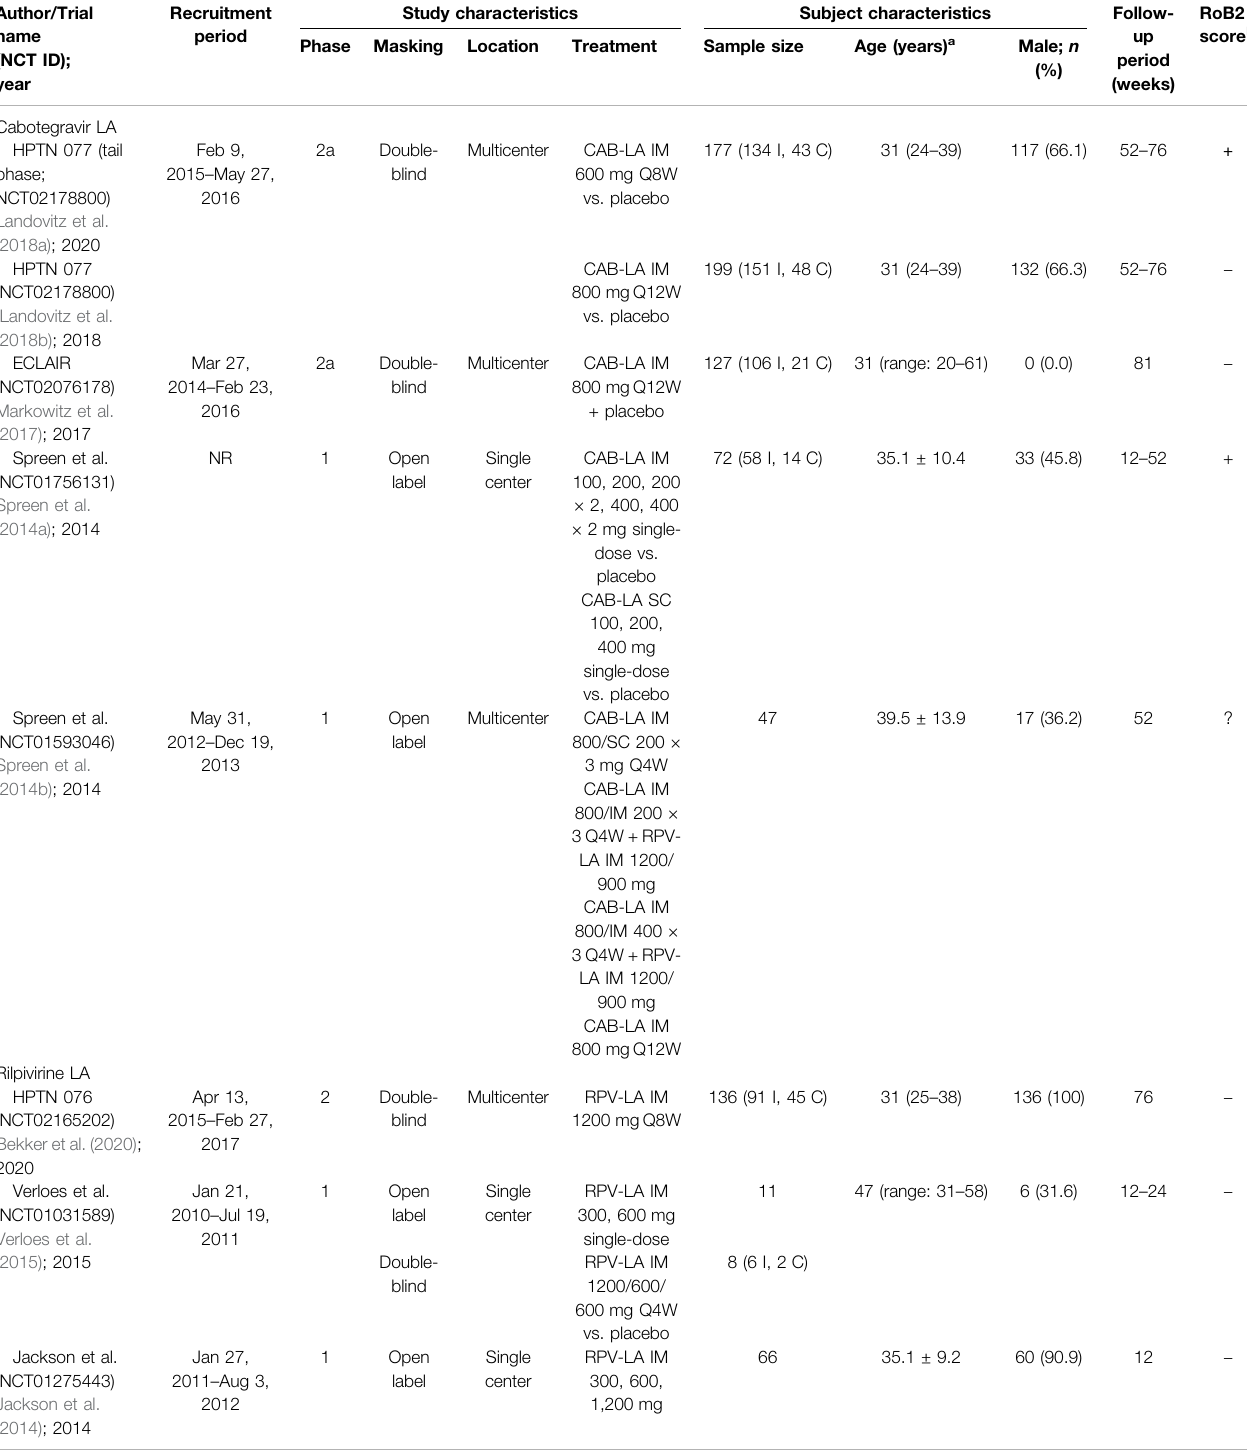
TABLE 1 | Characteristics of included studies and